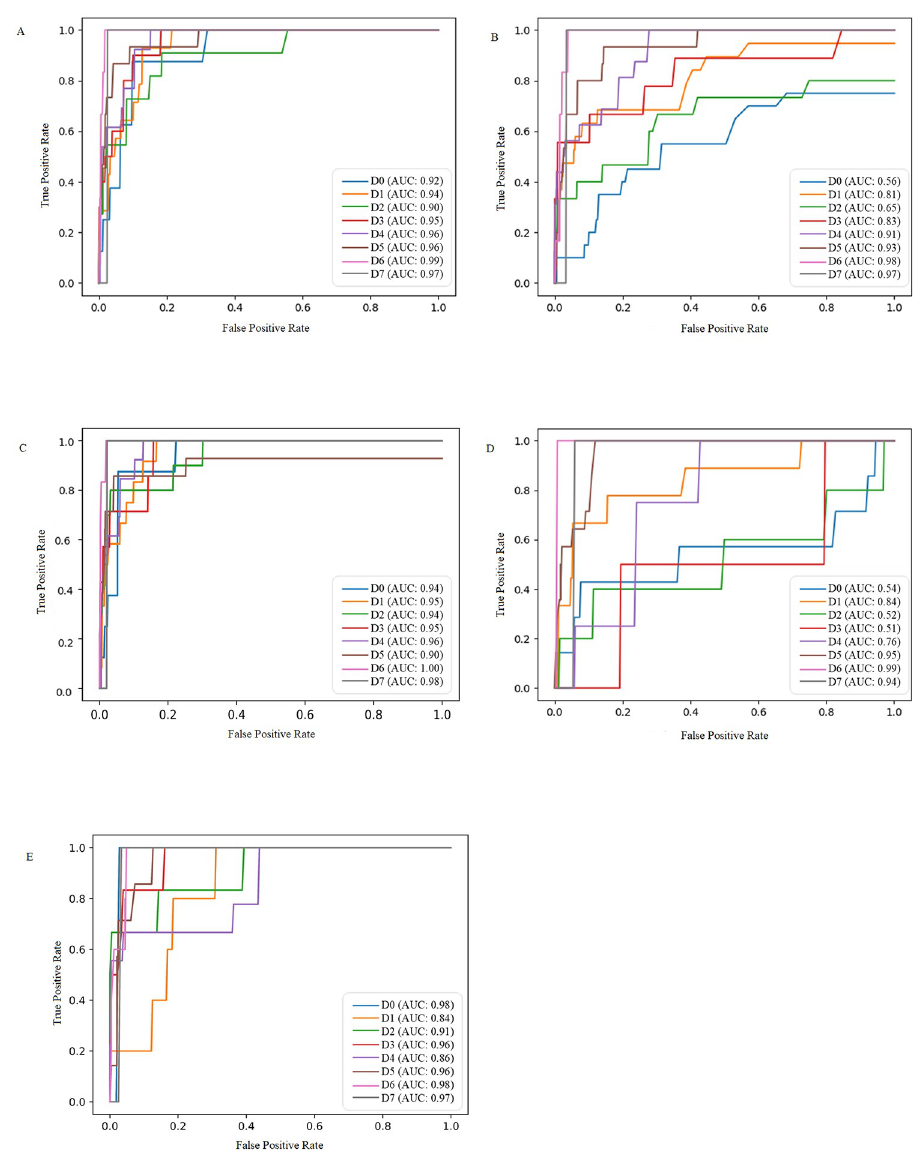
Fig 2. ROC of serum aspartate transaminase (AST) (Panel A), alanine transaminase (ALT) (Panel B), AST 2 /ALT (Panel C), activated partial thromboplastin time (aPTT) (Panel D), and AST/platelet count ratio index (APRI) (Panel E) in patients with dengue fever within 8 days of illness